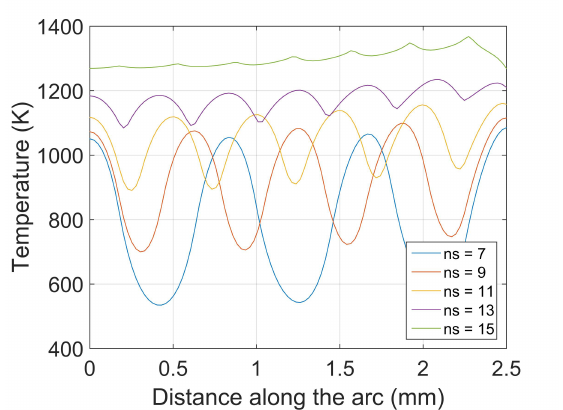
Figure 8. Temperature along the arc for the simulation presented in Figure 7. Our results are similar to those in [33]. ns represents the number of